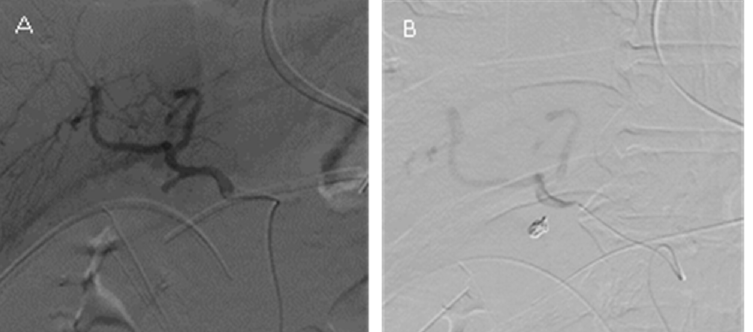
Figure 5. Angiography showing the preserved blood flow of the common and proper hepatic artery and distal branches after embolization with coils, but the GDA stump did not become filled with contrast material.